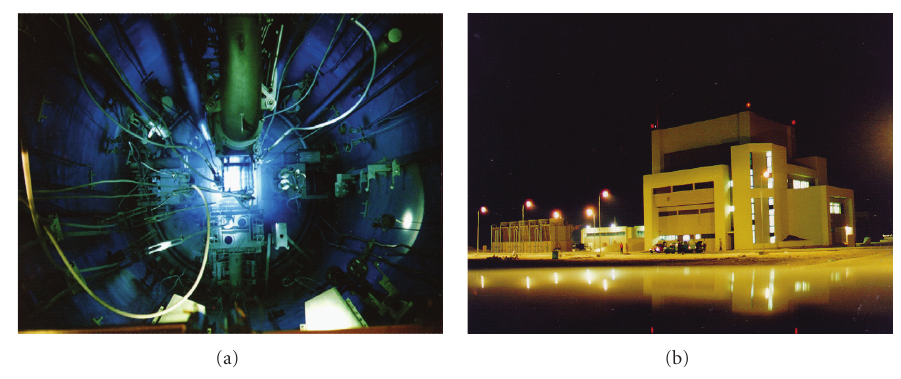
Figure 3: NUR research reactor.